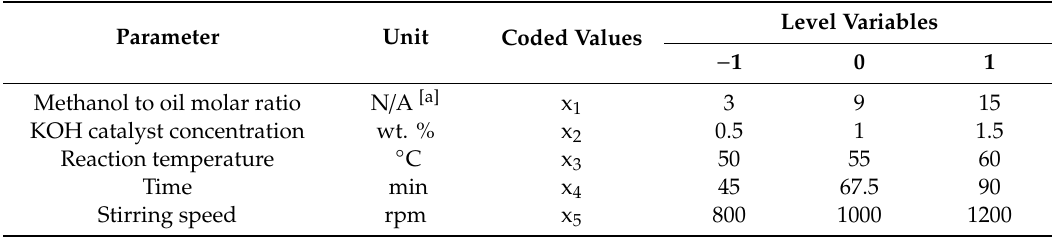
Table 4. Experimental ranges and levels of the independent variables in the Box–Behnken for transesterification of esterified C. manghas oil. Parameter